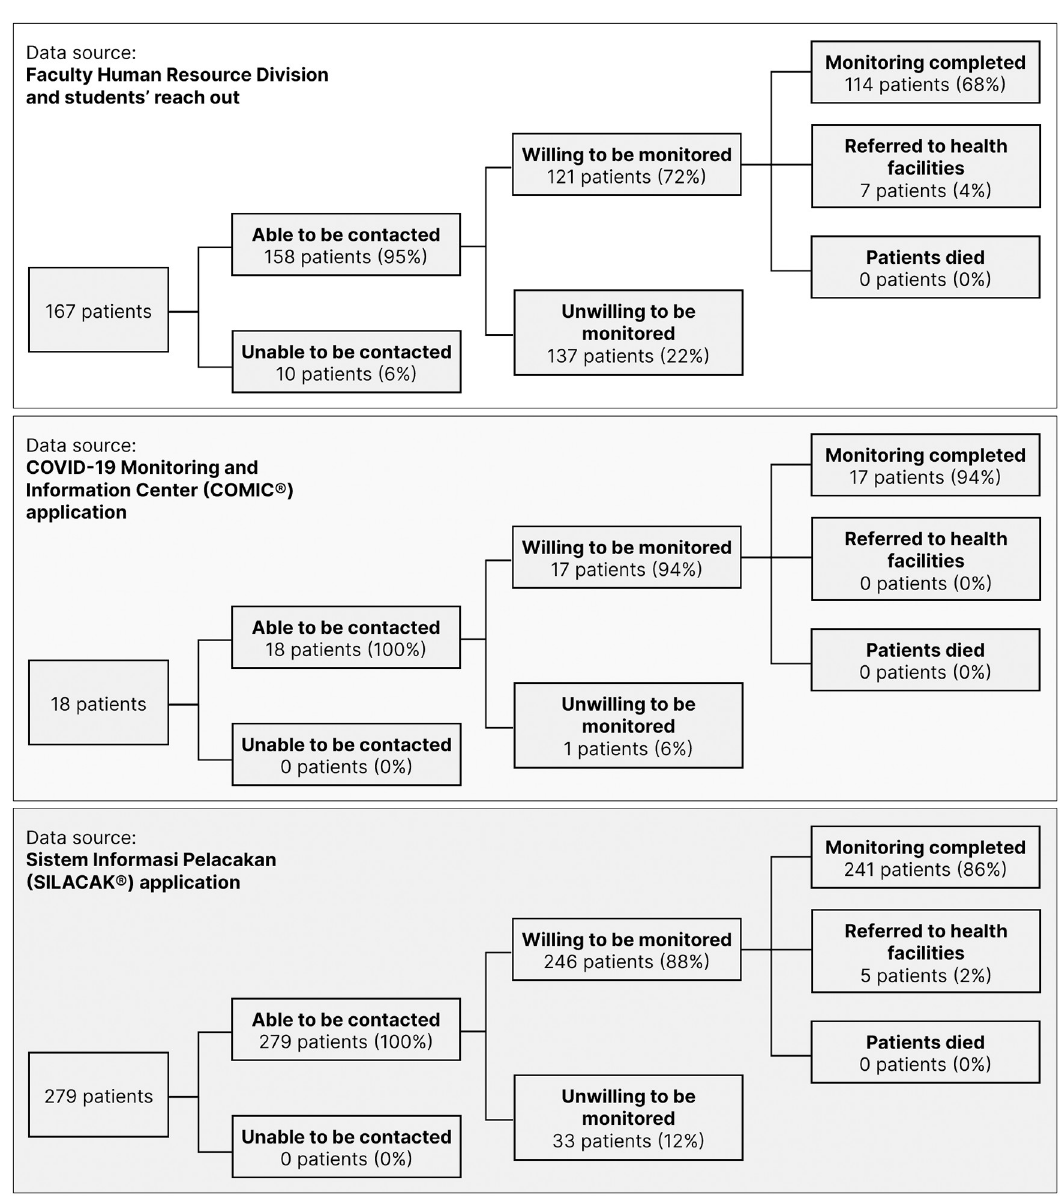
Fig 3. Patient monitoring cohorts of the 4-week